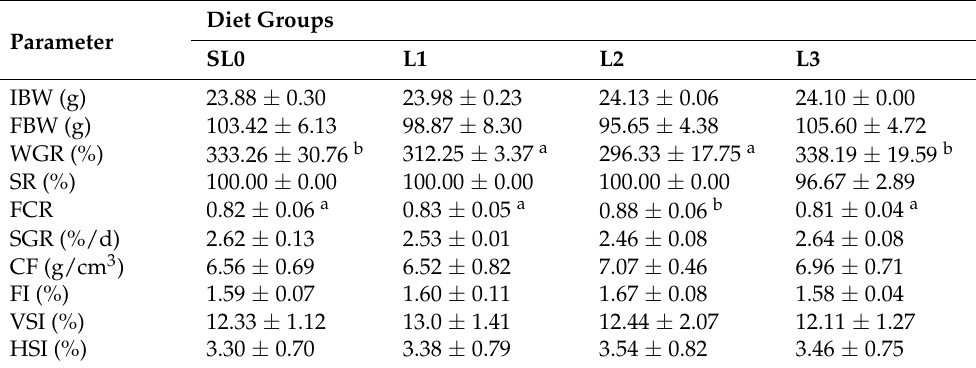
Table 3. Effect of diet supplementation with α -LA on the growth performance, morphology, and feed utilization of juvenile hybrid